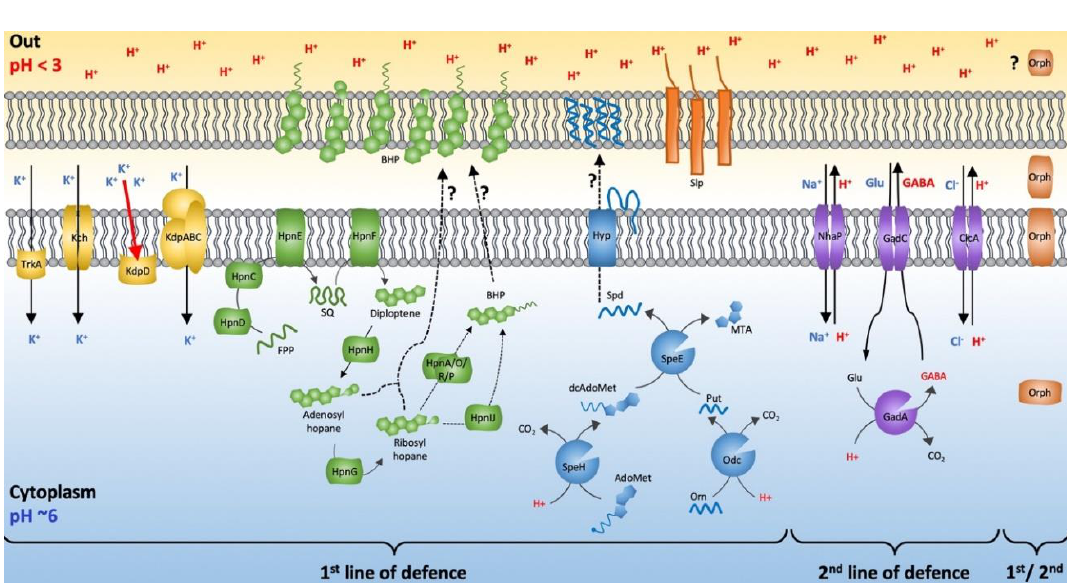
Figure 8. Model of acid resistance in Leptospirillum , categorized as either first line of defense involved in preventing the uptake of protons into the cell or second line of defense involved in neutralizing or expelling protons that enter the cell. Multiple hypothetical orphan genes (Orph) cluster with both first and second line of defense genes. The red arrow indicates that expression of KdpABC is activated by external K + sensed by KdpD. The cytoplasm is conjectured to be about pH 6, as has been found in other extreme acidophiles, although this has not been experimentally determined in Leptospirillum .